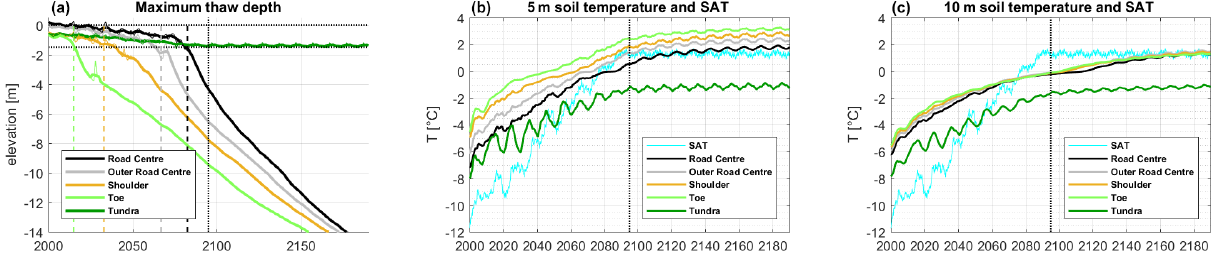
Figure A3. Climate stabilisation under RCP8.5 warming. Panel (a) illustrates the long-term evolution of maximum thaw depths (MTD) for all structural units for the vulnerable setting (MedRes, five tiles; see also Fig. 5). Panels ( b and c ) show soil temperatures at 5 and 10m depth below the tundra surface for the different structural units along with surface air temperature (5 year moving means). Dotted vertical black lines at 2095 correspond to the beginning of climate